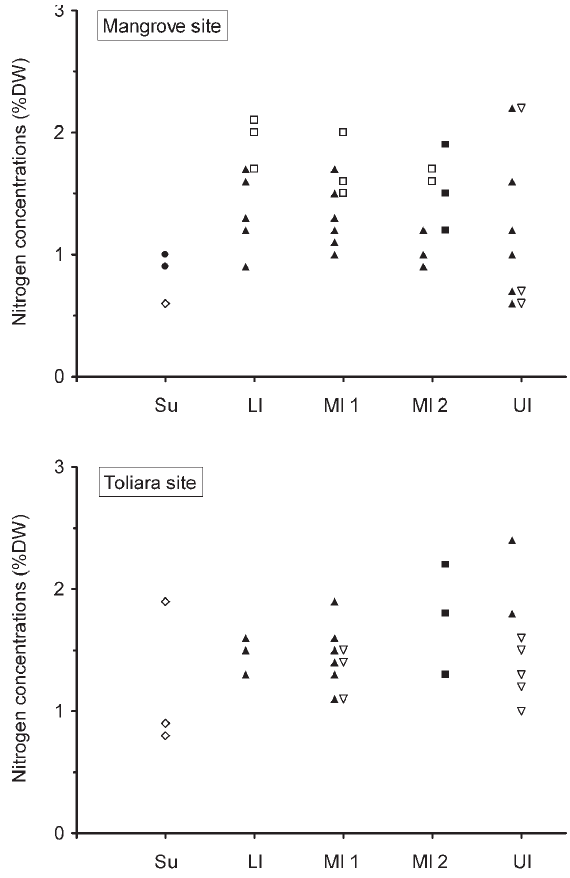
Fig . 2. – nitrogen concentrations (% dW) measured in seagrass spe- cies collected on toliara Beach and Beloza mangrove (madagascar) (sub: subtidal; li: low intertidal; mi1: mid-intertidal community 1, mi2: mid-intertidal community 2; ui: upper intertidal). ¢ : Cy- modocea rotundata , £ : Thalassia hemprichii , ò : Thalassodendron ciliatum , p : Halodule sp., s : Halophila ovalis, ◊ : Syringodium isoetifolium . Table 1. – mean values (n=3) of δ 13 c (‰), δ 15 n (‰), nitrogen concentration (% ) and c/n ratios (w:w) of seagrass collected along two dw transects made in the upper littoral zone of toliara Beach and a mangrove site. stations were randomly distributed along the upper intertidal limits, according to the seagrass patch occurrence. place station species n δ 13 c